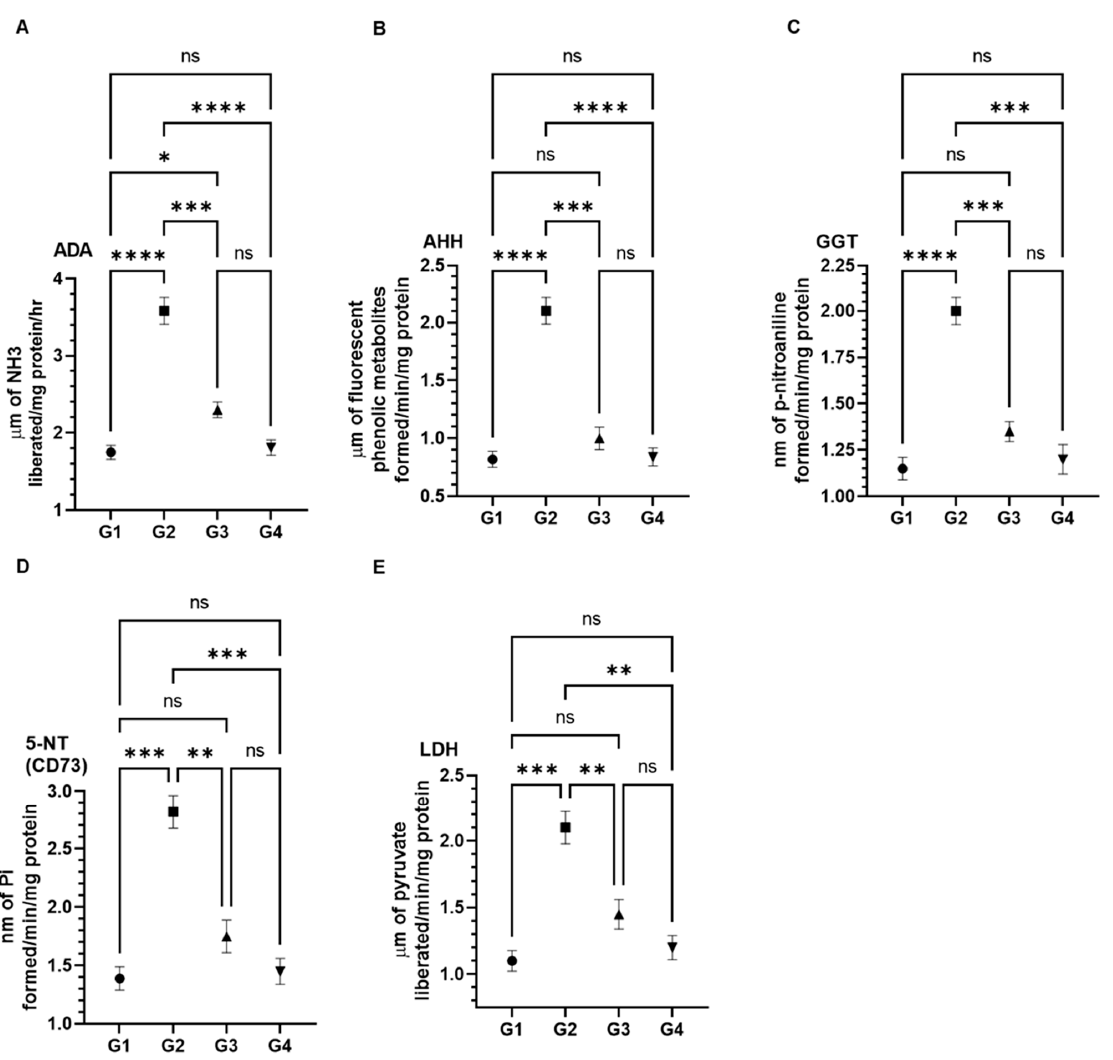
Commented [M3]: No subfigure (E) mentioned in Figure 5, please correct the figure Commented [AK4R3]: I have revised the Figure 5.